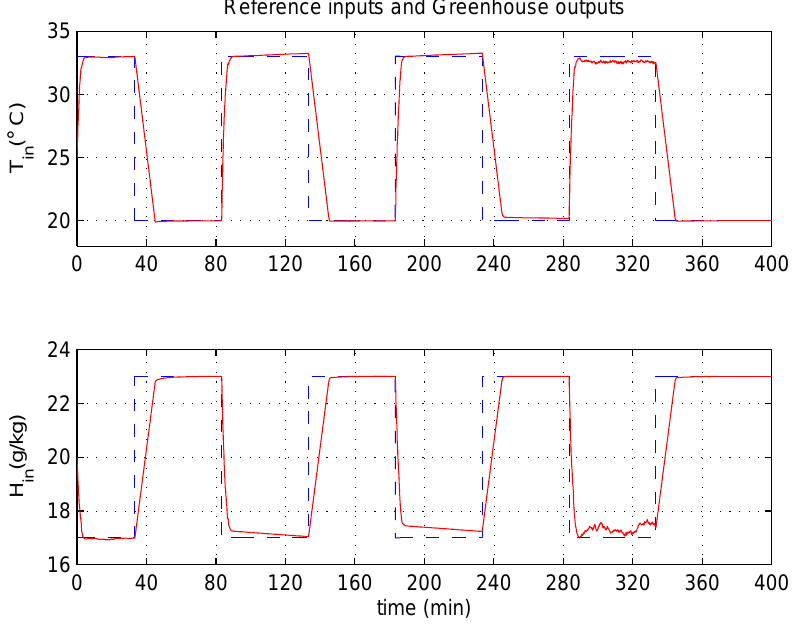
Figure 13. Conventional PID controller tracking trajectory of square-wave for temperature = 21 : 7780 ; K and humidity ratio, K p 1 K = 47 : 4968 ; K = 97 : 0353 . i 2 d 2